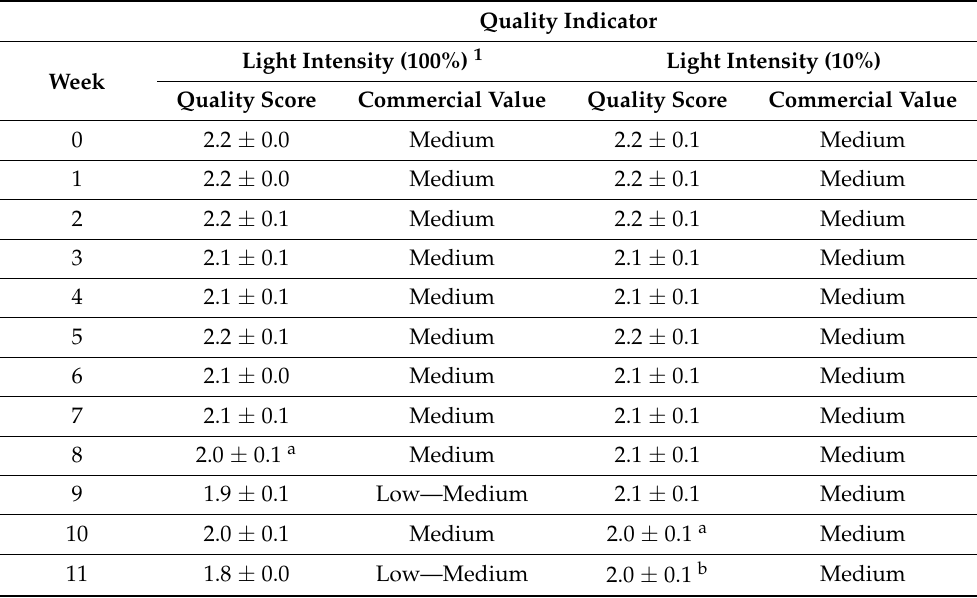
Table 4. Quality indicators of green tea plants grown in reduced light intensity (90% opacity) compared to full ambient sunlight conditions over 11